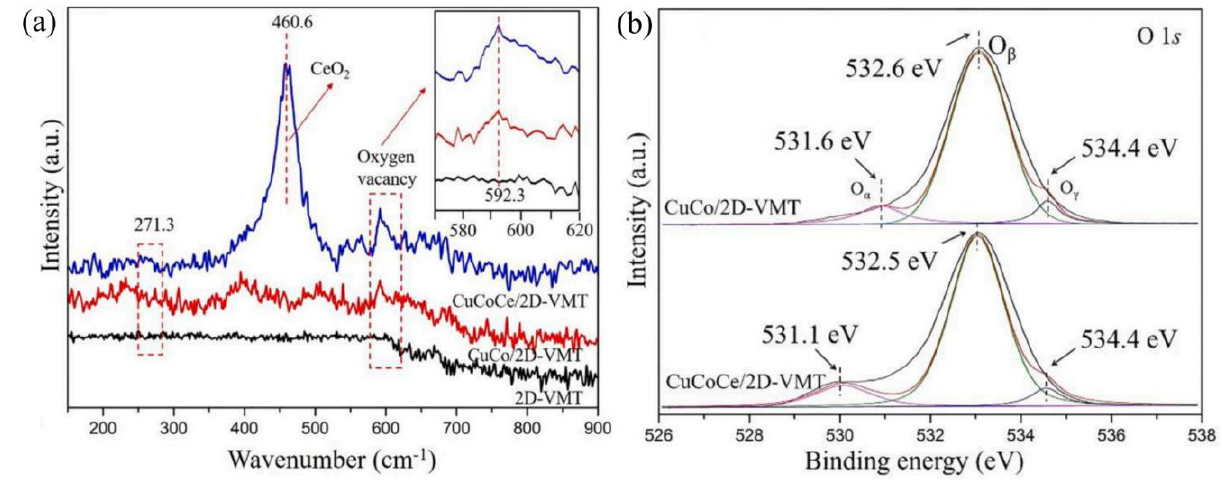
Figure 3. ( a ) Raman spectra of CuCoCe/2D-VMT, CuCo/2D-VMT, and 2D-VMT catalysts and ( b ) XPS spectra of O 1 s . Reproduced from [44] with